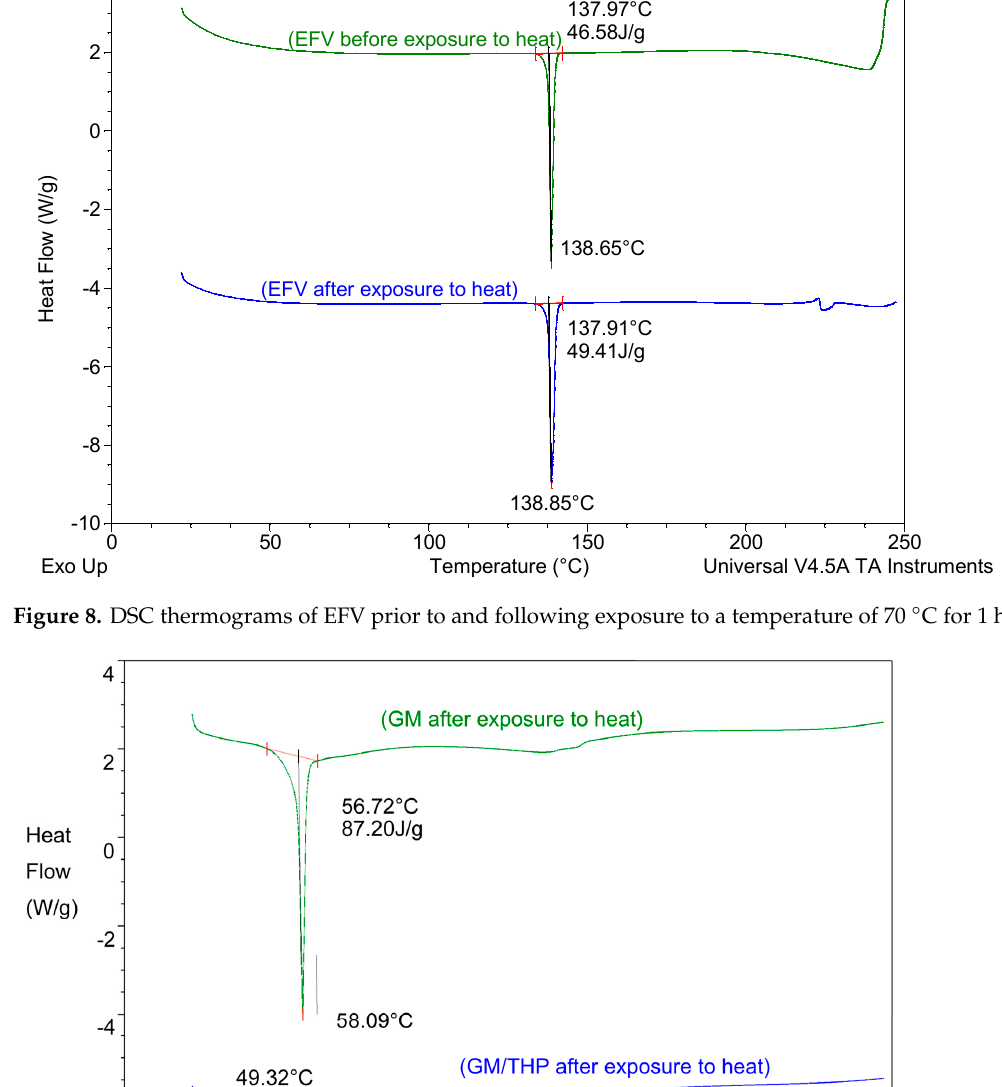
Figure 9. DSC thermograms of GM and of a binary mixture of GM and THP generated following exposure to 70 °C for 1 h.